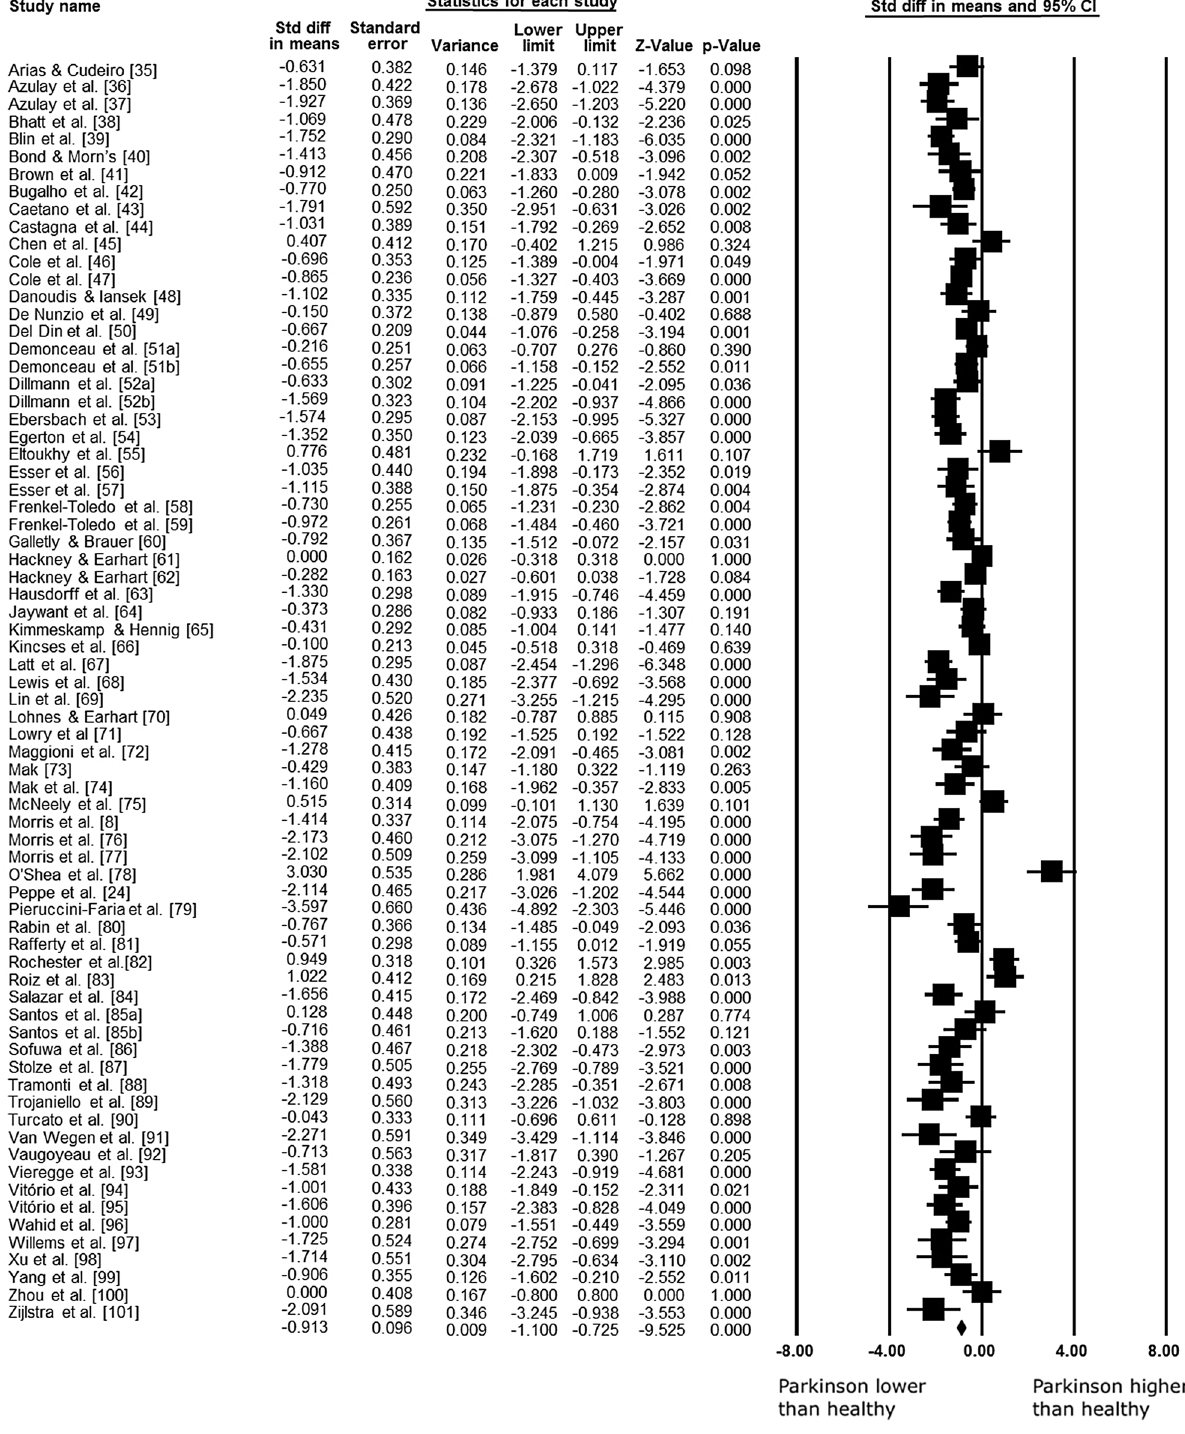
Figure 2. Standardized mean differences on gait speed between Parkinson and healthy individuals. CI confidence interval, Std diff standardized